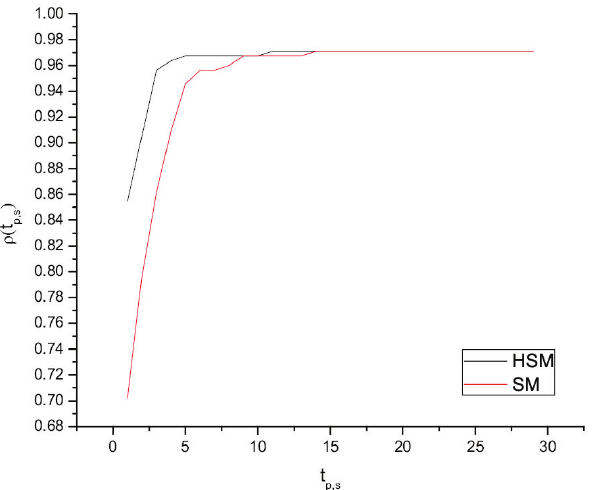
Figure 2. Performance profiles for the HSM and SM methods regarding the CPU time metric.